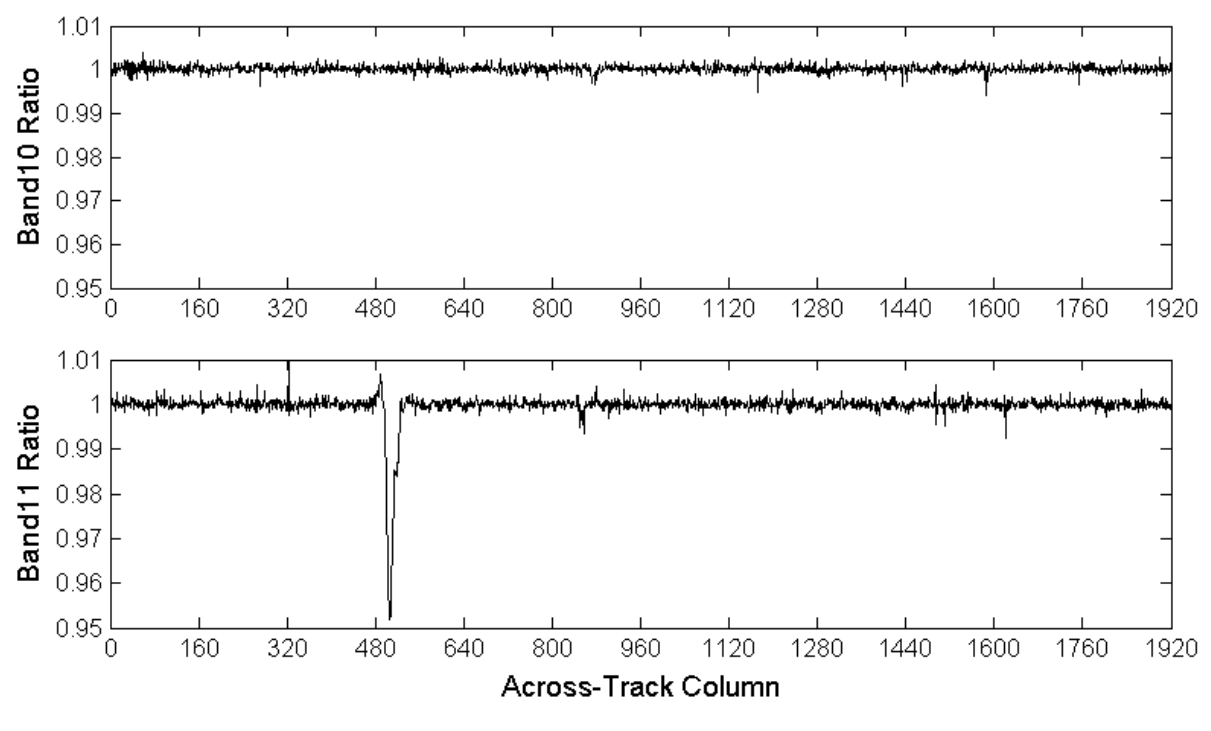
Figure 8. Ratio between the pre-flight on-board calibrator (OBC) measurement in TVAC and the on-orbit OBC data for Band 10 ( top ) and Band 11 ( bottom ). The 5% drop in the ratio on Band 11 around Column 500 is due to contamination that developed on the Band 11 spectral